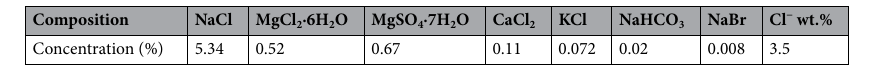
Table 2. Concentration table of artificial seawater preparation.